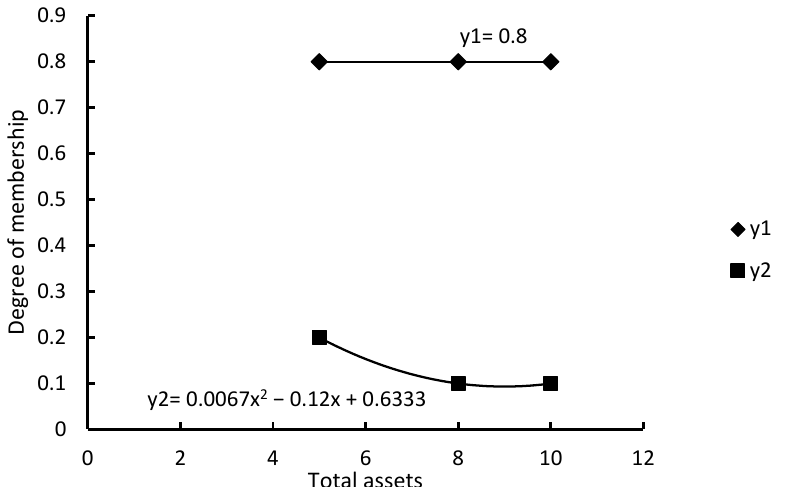
Figure A3. Single factor evaluation for the index of total assets (0–10 (inclusive) ten thousand yuan).